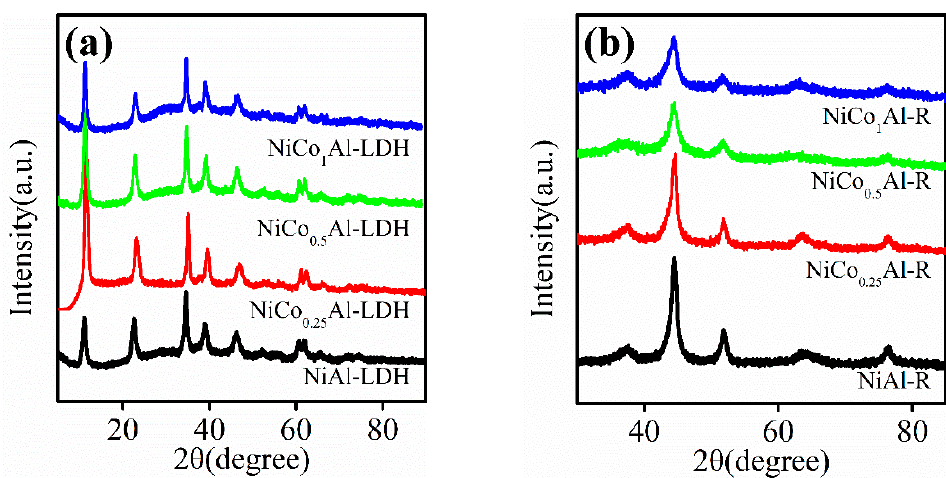
Figure 1. XRD profiles of NiCo x Al-LDHs ( a ) and NiCo x Al-R catalysts ( b ).